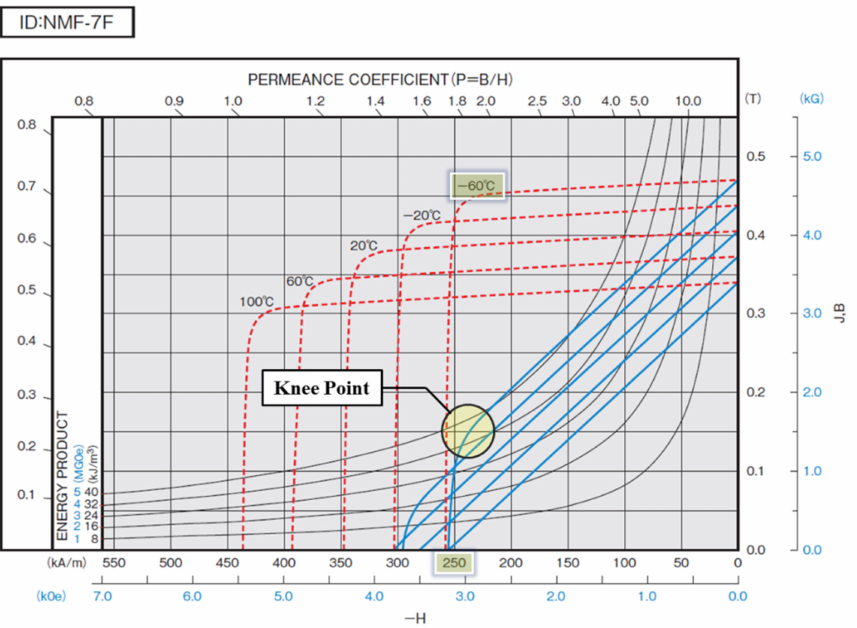
Figure 12. B-H curve according to the temperature of ferrite permanent magnet (NMF-7)